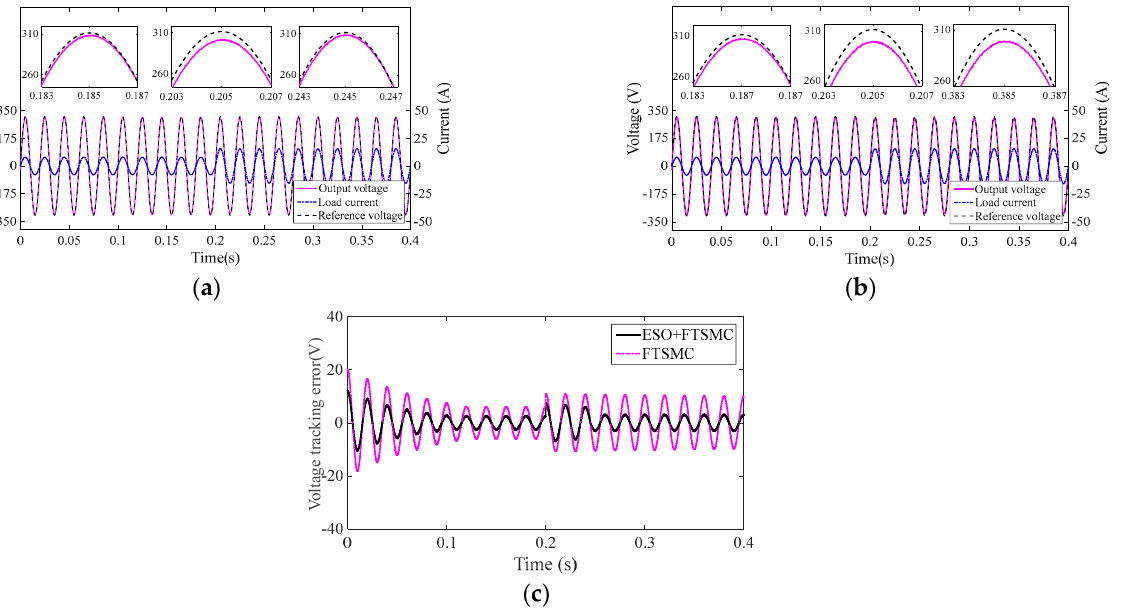
Figure 5. Inverter system output response under linear load saltation: ( a ) output response of System 1, ( b ) output response of System 2, and ( c ) voltage error.